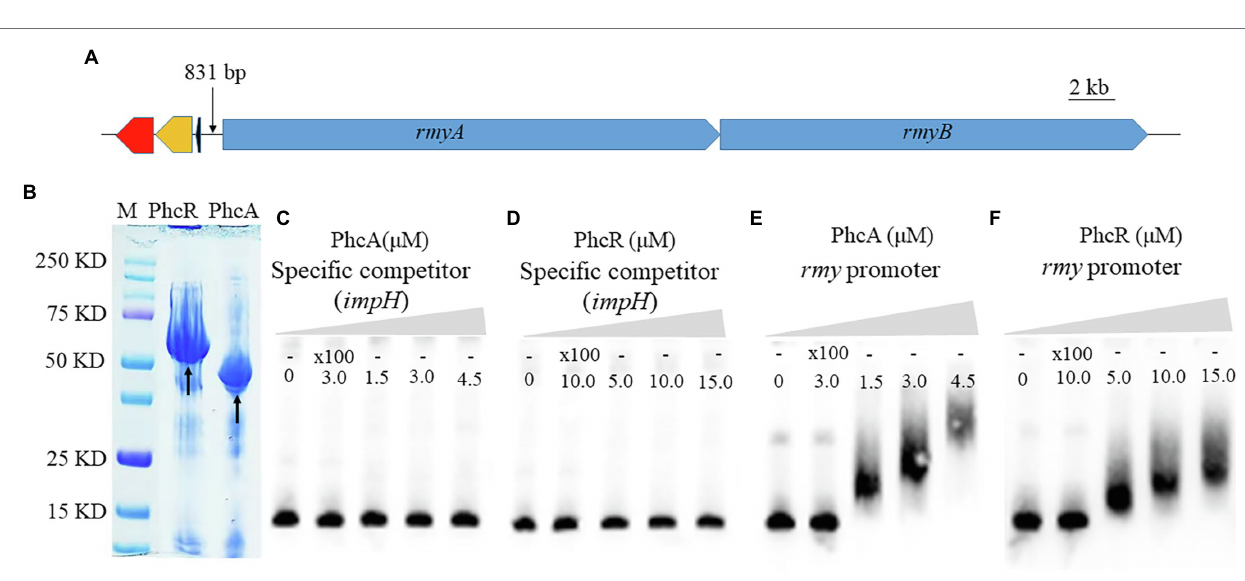
FIGURE 6 | Schematic presentation of rmyA and rmyB operons (A) , proteins (PhcA and PhcR) expression (B) and promoter binding detection by electrophoretic mobility shift assay (E,F) . 30 fmol of labeled DNA fragments corresponding to the promoter region of rmyA gene was incubation with 100 nm and 200 nm PhcA/R, respectively, using 100-fold unlabeled corresponding DNA fragments as the specific competitor. The coding sequence of impH (424 bp), which encodes a type VI secretion protein and is not bound by PhcA and PhcR, was used as a negative control in the EMSA experiment (C,D) . The positions of free DNA and of protein– DNA complexes were